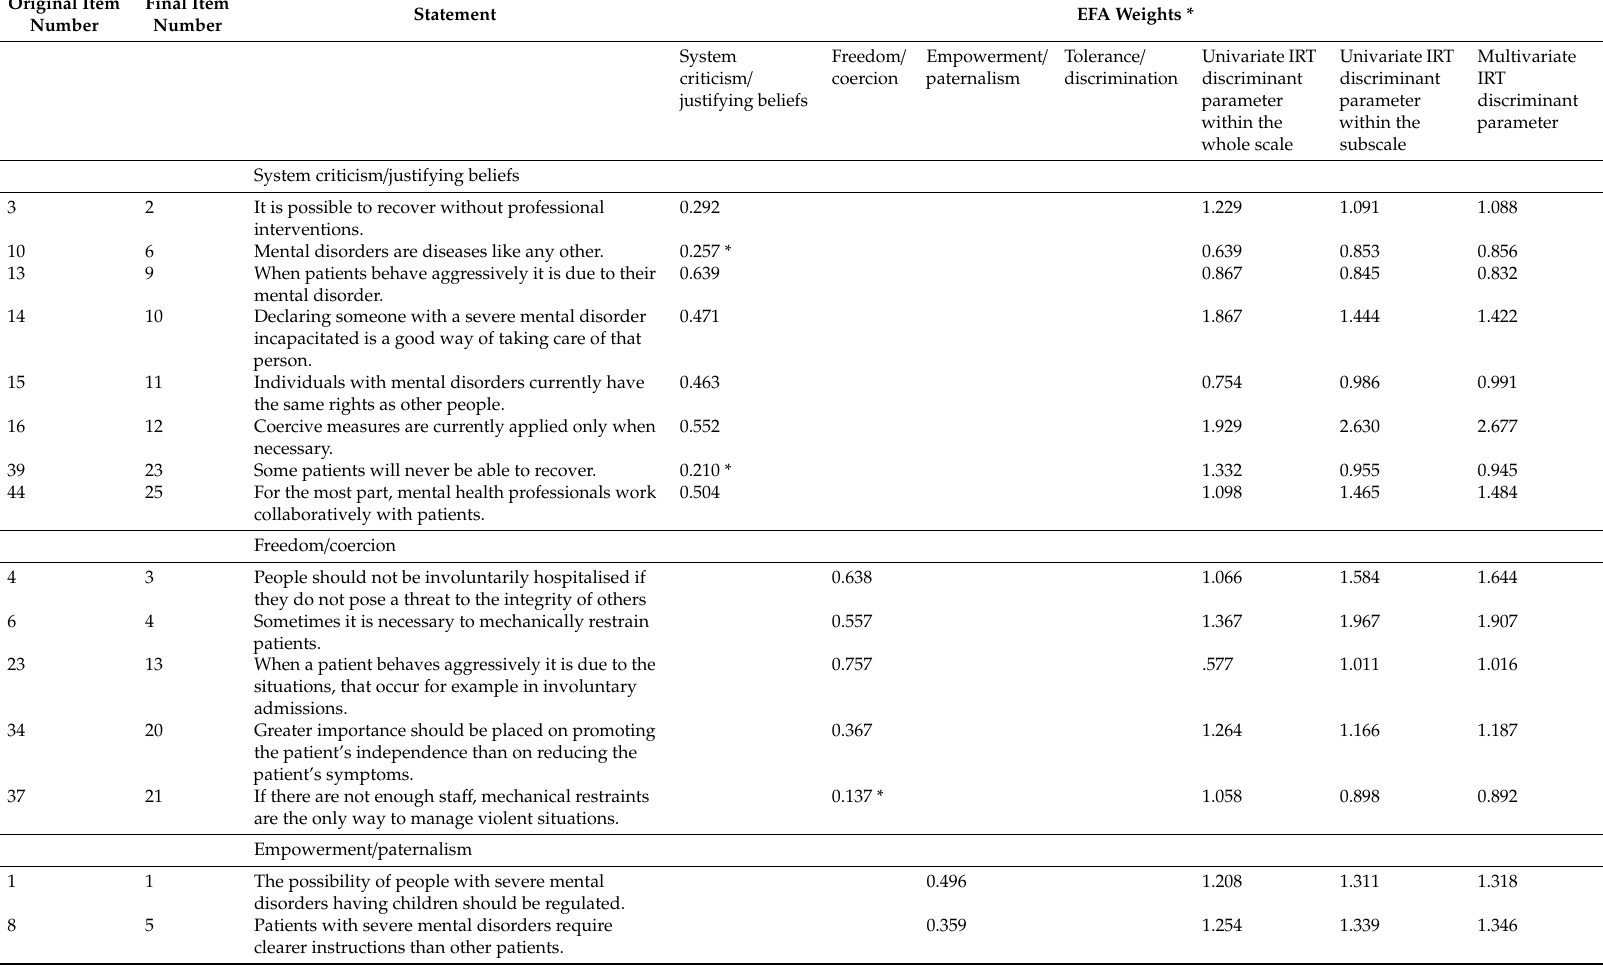
Table 2. Factorial weights and discrimination data of the final item